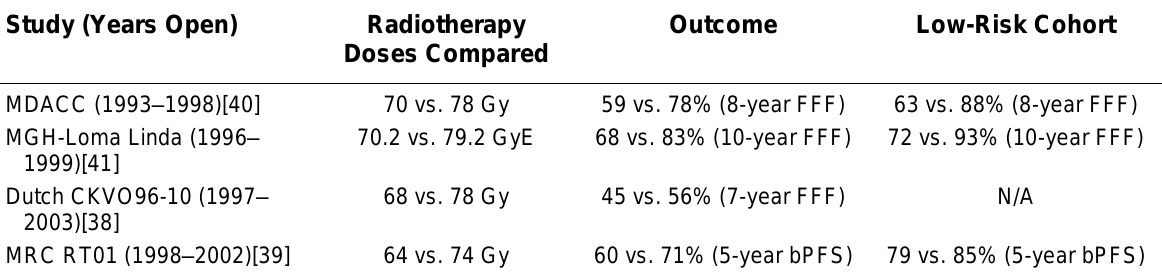
Randomized Trials Investigating Dose Escalation of